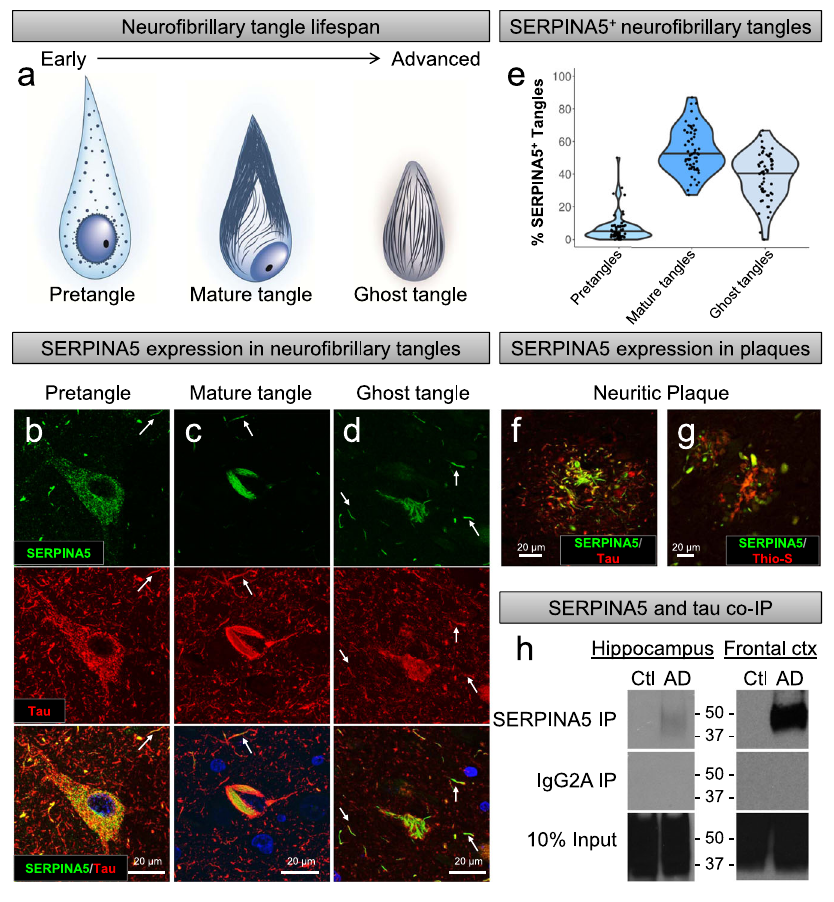
Fig. 6 SERPINA5 is a tau interactor expressed in neuro fi brillary tangles and neuritic plaques. a Cartoon depiction of the lifespan of neuro fi brillary tangle maturity ranging from early to advanced forms: pretangle with punctate tau staining, mature tangle with fi brillar tau, and ghost tangle in which only the remnants of the mature tangle remain once the neuron has died. b SERPINA5 accumulates alongside, as well as colocalizes with punctate tau (Tau E178, red) in pretangles. c SERPINA5 accumulates in areas fairly devoid of tau and colocalizes along the fi brillar aspect of tau (Tau E178, red) in mature tangles. d SERPINA5 accumulates in the extracellular space and to a lesser extent colocalizes with tau (Tau pS396, red) in ghost tangles. SERPINA5 is also observed in a subset of dystrophic neurites (arrows, b – d ). e Manual quanti fi cation of SERPINA5-positive neuro fi brillary tangle counts in CA1 region of the posterior hippocampus shows a greater frequency of mature tangles and ghost tangles. Pretangles, mature tangles, and ghost tangles were manually quanti fi ed. f , g SEPRINA5 accumulates independently and colocalizes with tau in neuritic plaques as shown by tau (E1) staining and thio fl avin-S. Immuno fl uorescent staining experiments were performed successfully in triplicate for AD and controls. h Immunoblot of tau (E1) using immunoprecipitated SERPINA5 demonstrates a tau-SERPINA5 protein complex in the AD brain, but not in control brain. (Left) Tissue was sampled from frozen hippocampi of a 73-year-old male control (Braak = I, Thal = 0) and an 86-year-old male AD case (Braak = V and Thal = 5). (Right) Tissue was sampled from frozen frontal cortices of a 75-year-old female control (Braak = I, Thal = 0) and a 68-year-old male AD case (Braak = VI and Thal = 5). AD, Alzheimer ’ s disease; Ctl, control; co-IP, co-immunoprecipitation; Thio-S, thio fl avin-S. Note: uncropped western blots can be found in Supplementary Figs. 19 and